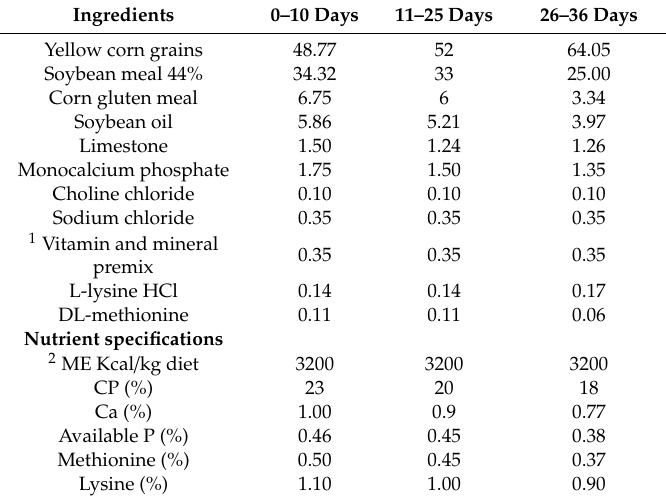
Table 1. Ingredient composition and calculated nutrient analysis of starter (1–10 days), grower (11–25 days), and finisher (26–36 days) diets.